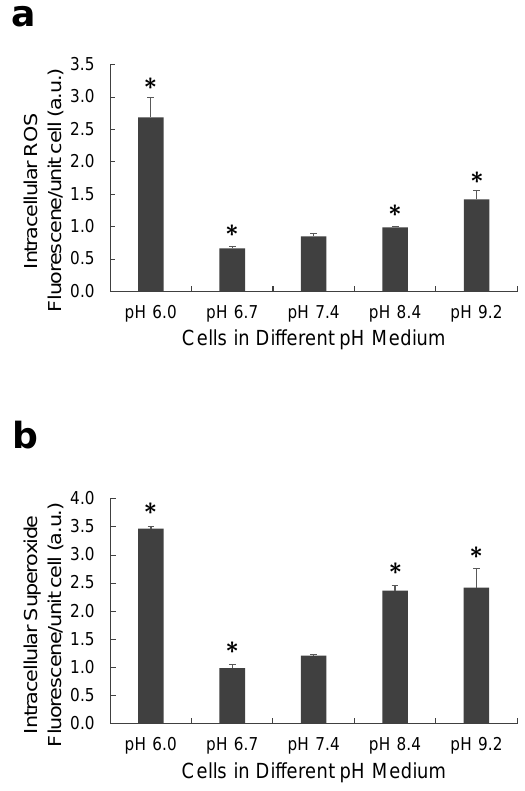
Figure 6. The effect of pH on the levels of intracellular reactive oxygen species (ROS) in MDA-MB-231 cells. MDA-MB-231 cells were seeded in a 12-well plate and they were incubated at five different pHs of DMEM: pH 6.0, pH 6.7, pH 7.4, pH 8.4, and pH 9.2. ( a ) Intracellular ROS or H 2 O 2 is measured by CM-H2DCFDA ( p < 0.05 (*) from the control pH 7.4). ( b ) The level of intracellular superoxide is also obtained by DHE ( p < 0.05 (*) from the control pH 7.4).